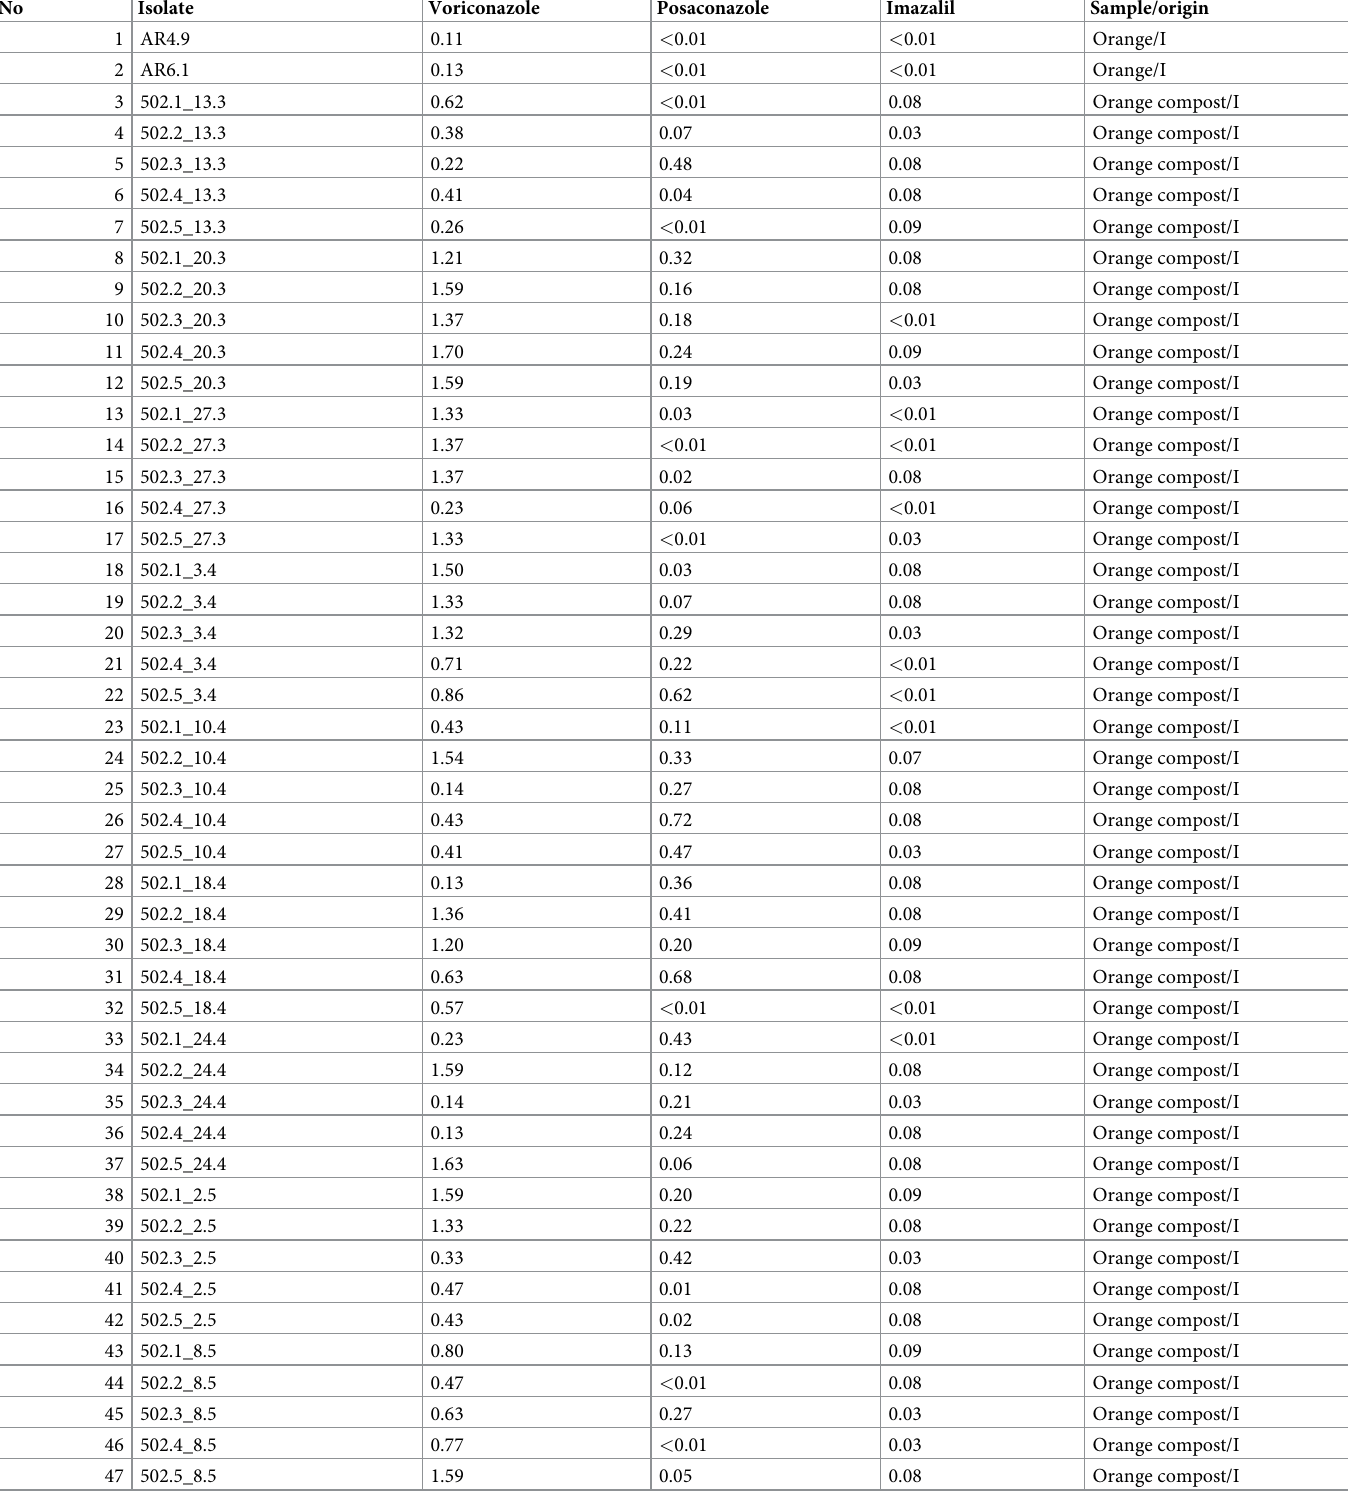
Table 2. Sensitivity to three DMI fungicides (EC 50 ) of Aspergillusfumigatus isolates from orange fruits and orange-based compost.